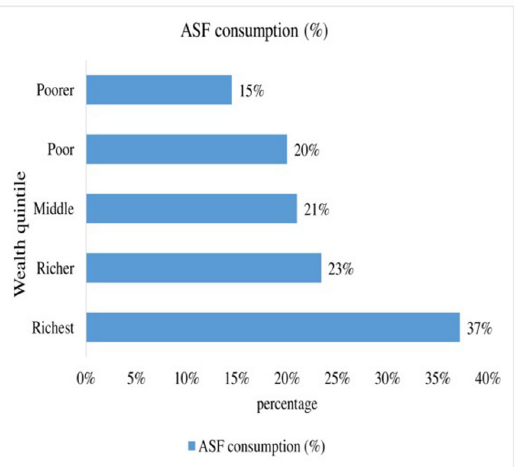
Fig 1. ASF consumption by household wealth status among children aged 6–23 months in